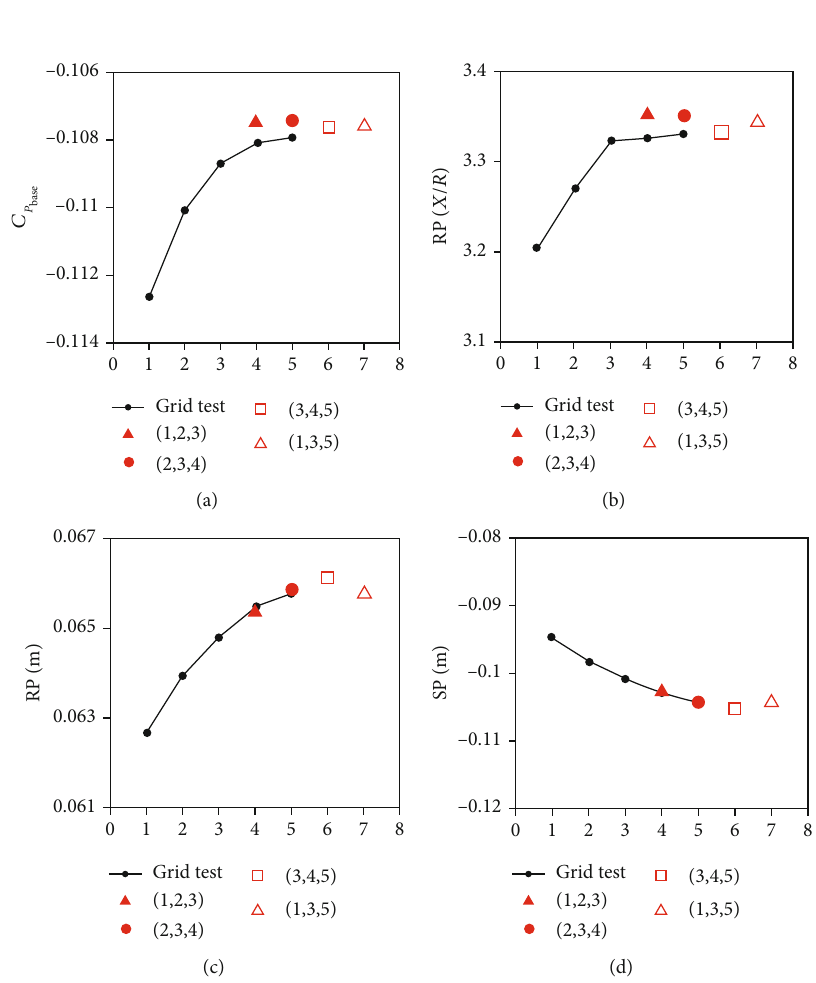
Figure 3: Extrapolated values from GCI w.r.t. QoIs. (a, b) Axisymmetric base. (c, d) 24-deg compression